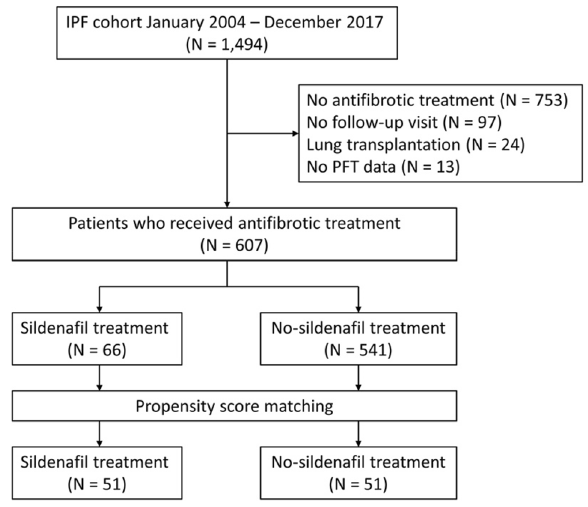
Figure 1. Study flow. IPF, idiopathic pulmonary fibrosis; PFT, pulmonary function